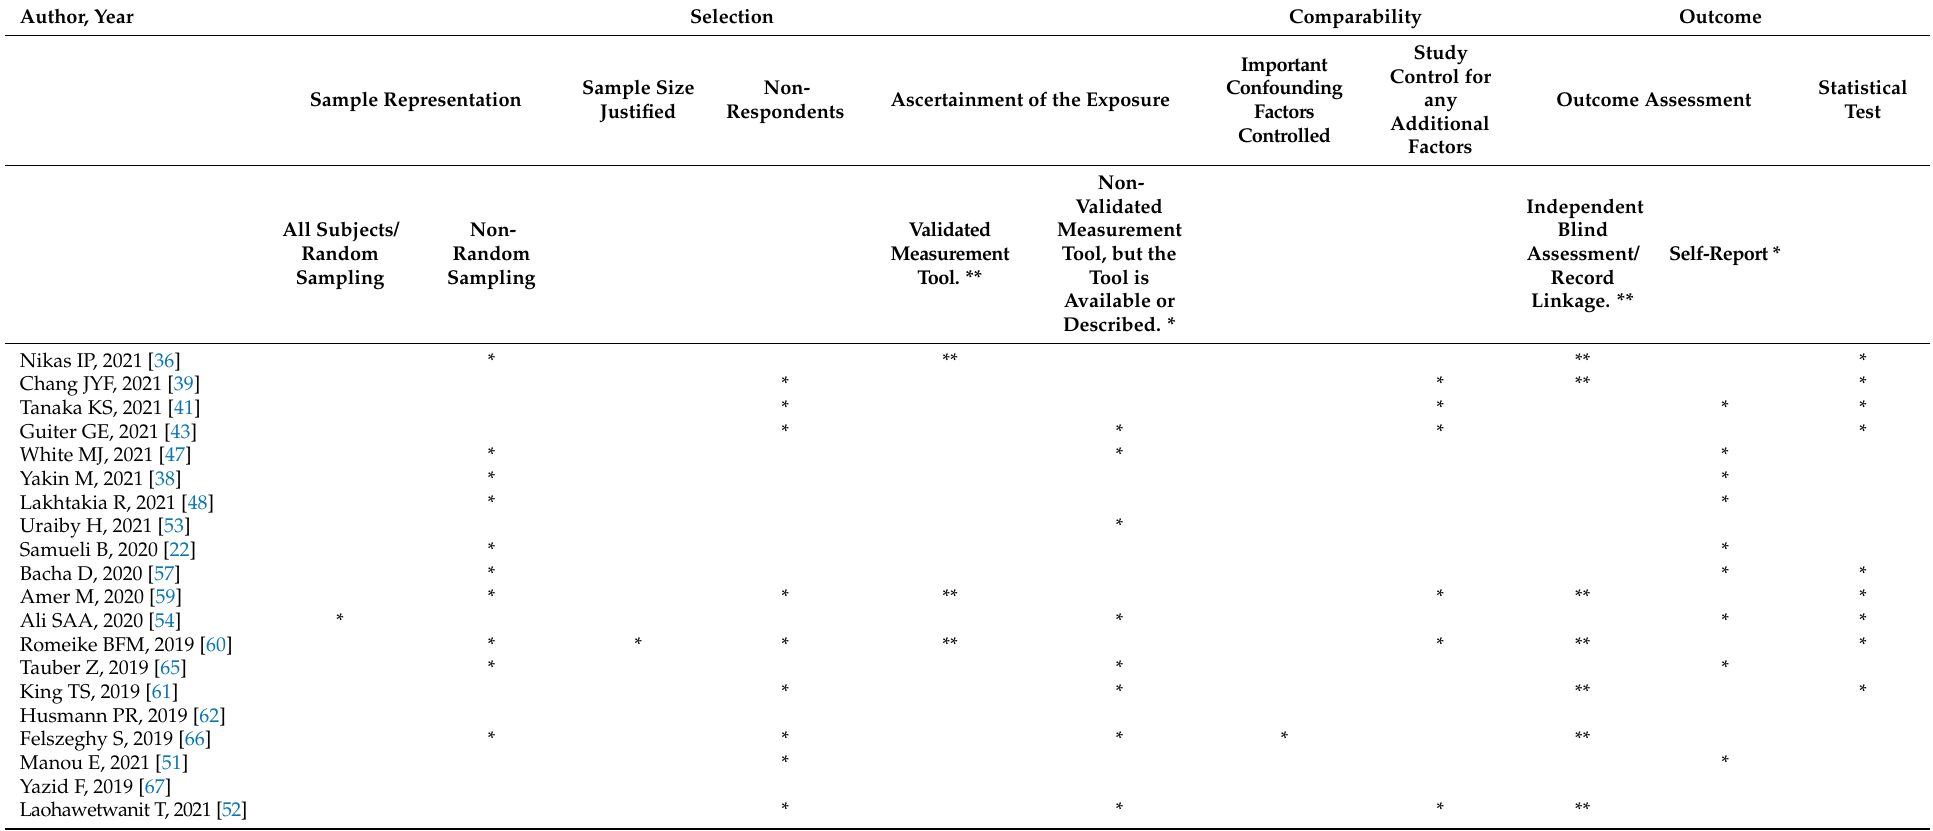
Table 3. Summary of quality assessment of cross-sectional studies using the NOS